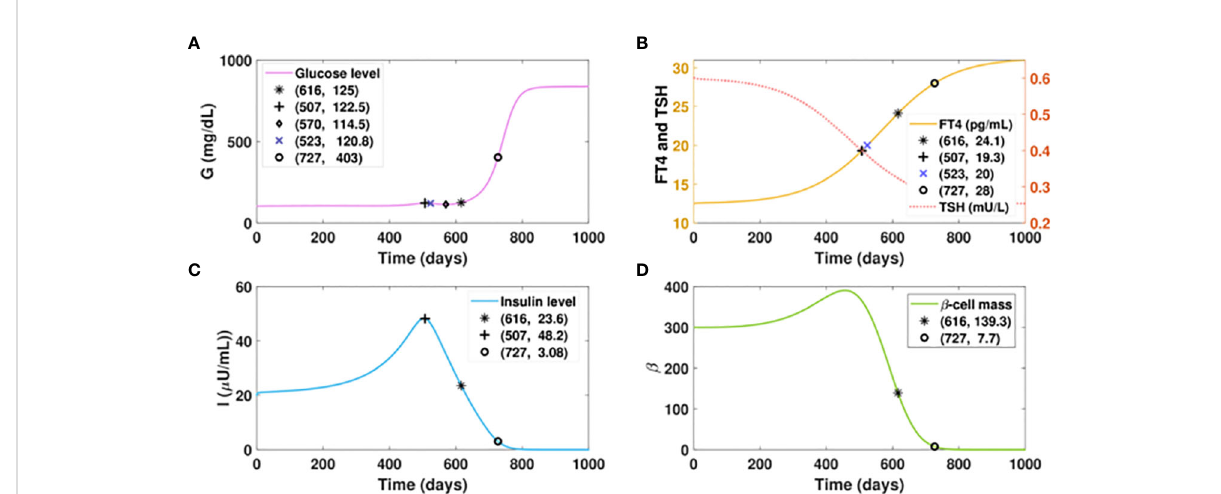
FIGURE 5 Dynamics of glucose, insulin, and functional beta-cell mass level with fast progressing hyperthyroidism. (A-D) Time evolution of blood glucose concentration, plasma FT4 and TSH concentrations, insulin level, and functional betacellmass. The initial conditions of FT4 and TSH are set to be 12.5 pg/ml and 0.6 mU/l, respectively. The parametervalues are listed in Table 1. We assume the FT4 synthesis factor for patient A to be a 1 ( t ) = 6 : 9 + 30 . Withthe gradual elevation of FT4, the glucose level of this patient would reach 122.5 mg/dl on day 507. The glucose wouldbe 1+ e (6 − 0 : 01 t ) dragged down slightly to 114.5 mg/dl in 63 days by improved insulin sensitivity. However, the glucose level wouldrise again